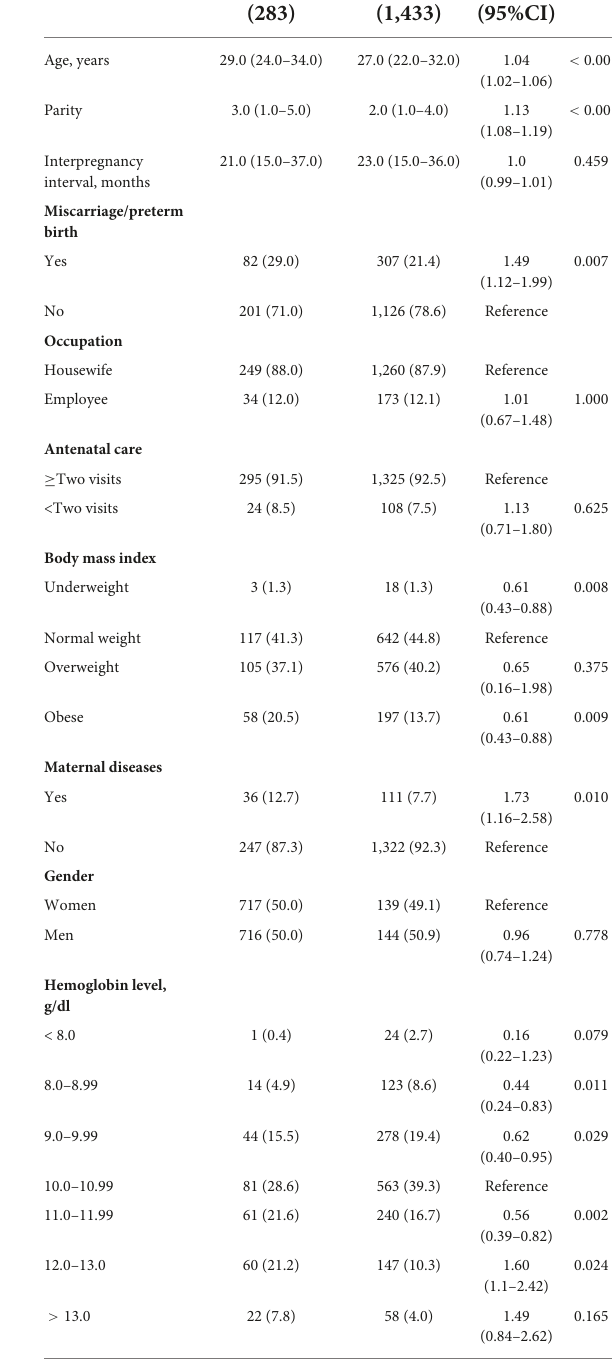
TABLE 2 Comparing sociodemographic and clinical variables between mothers with preterm birth and mothers with term birth in Khartoum, Sudan,